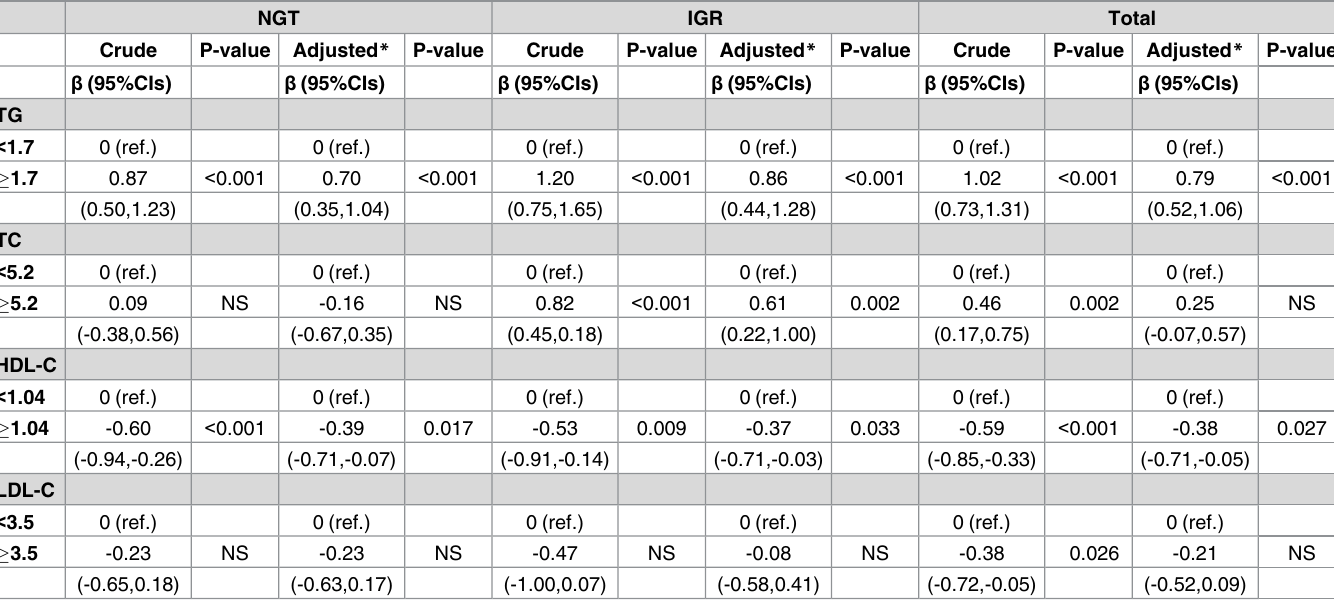
Table 3. Multiple regression analysis of lipid indices associated with